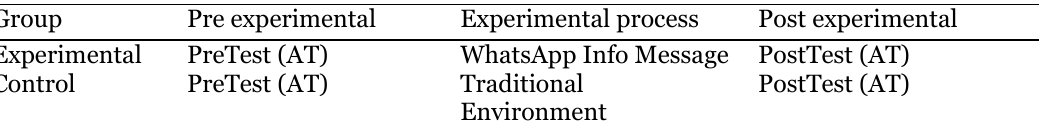
Quasi Experimental Design Research View Group Pre experimental Experimental process Post experimental Experimental PreTest (AT) WhatsApp Info Message PostTest (AT) Control PreTest (AT) Traditional PostTest Environment